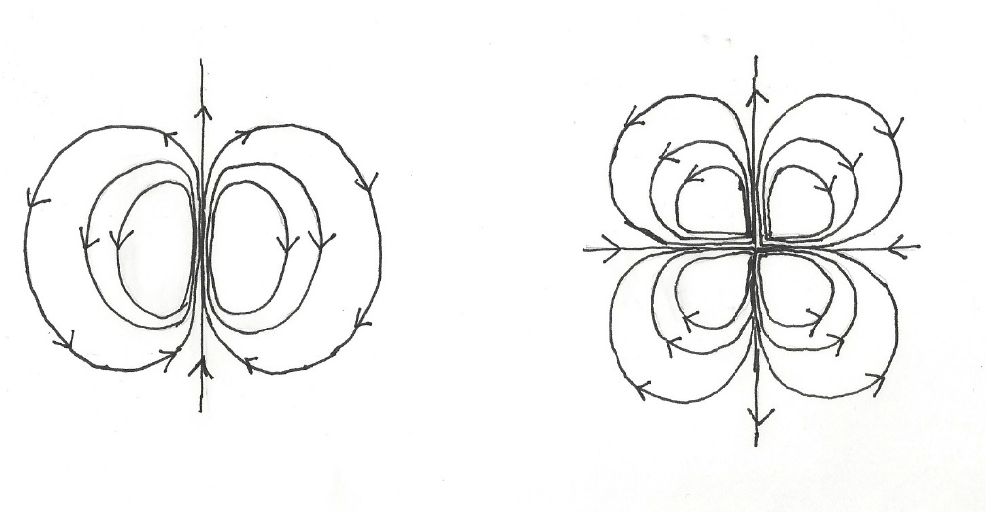
Figure 4. Schematic diagrams of dipolar ( left ) and quadrupolar ( right ) B -field